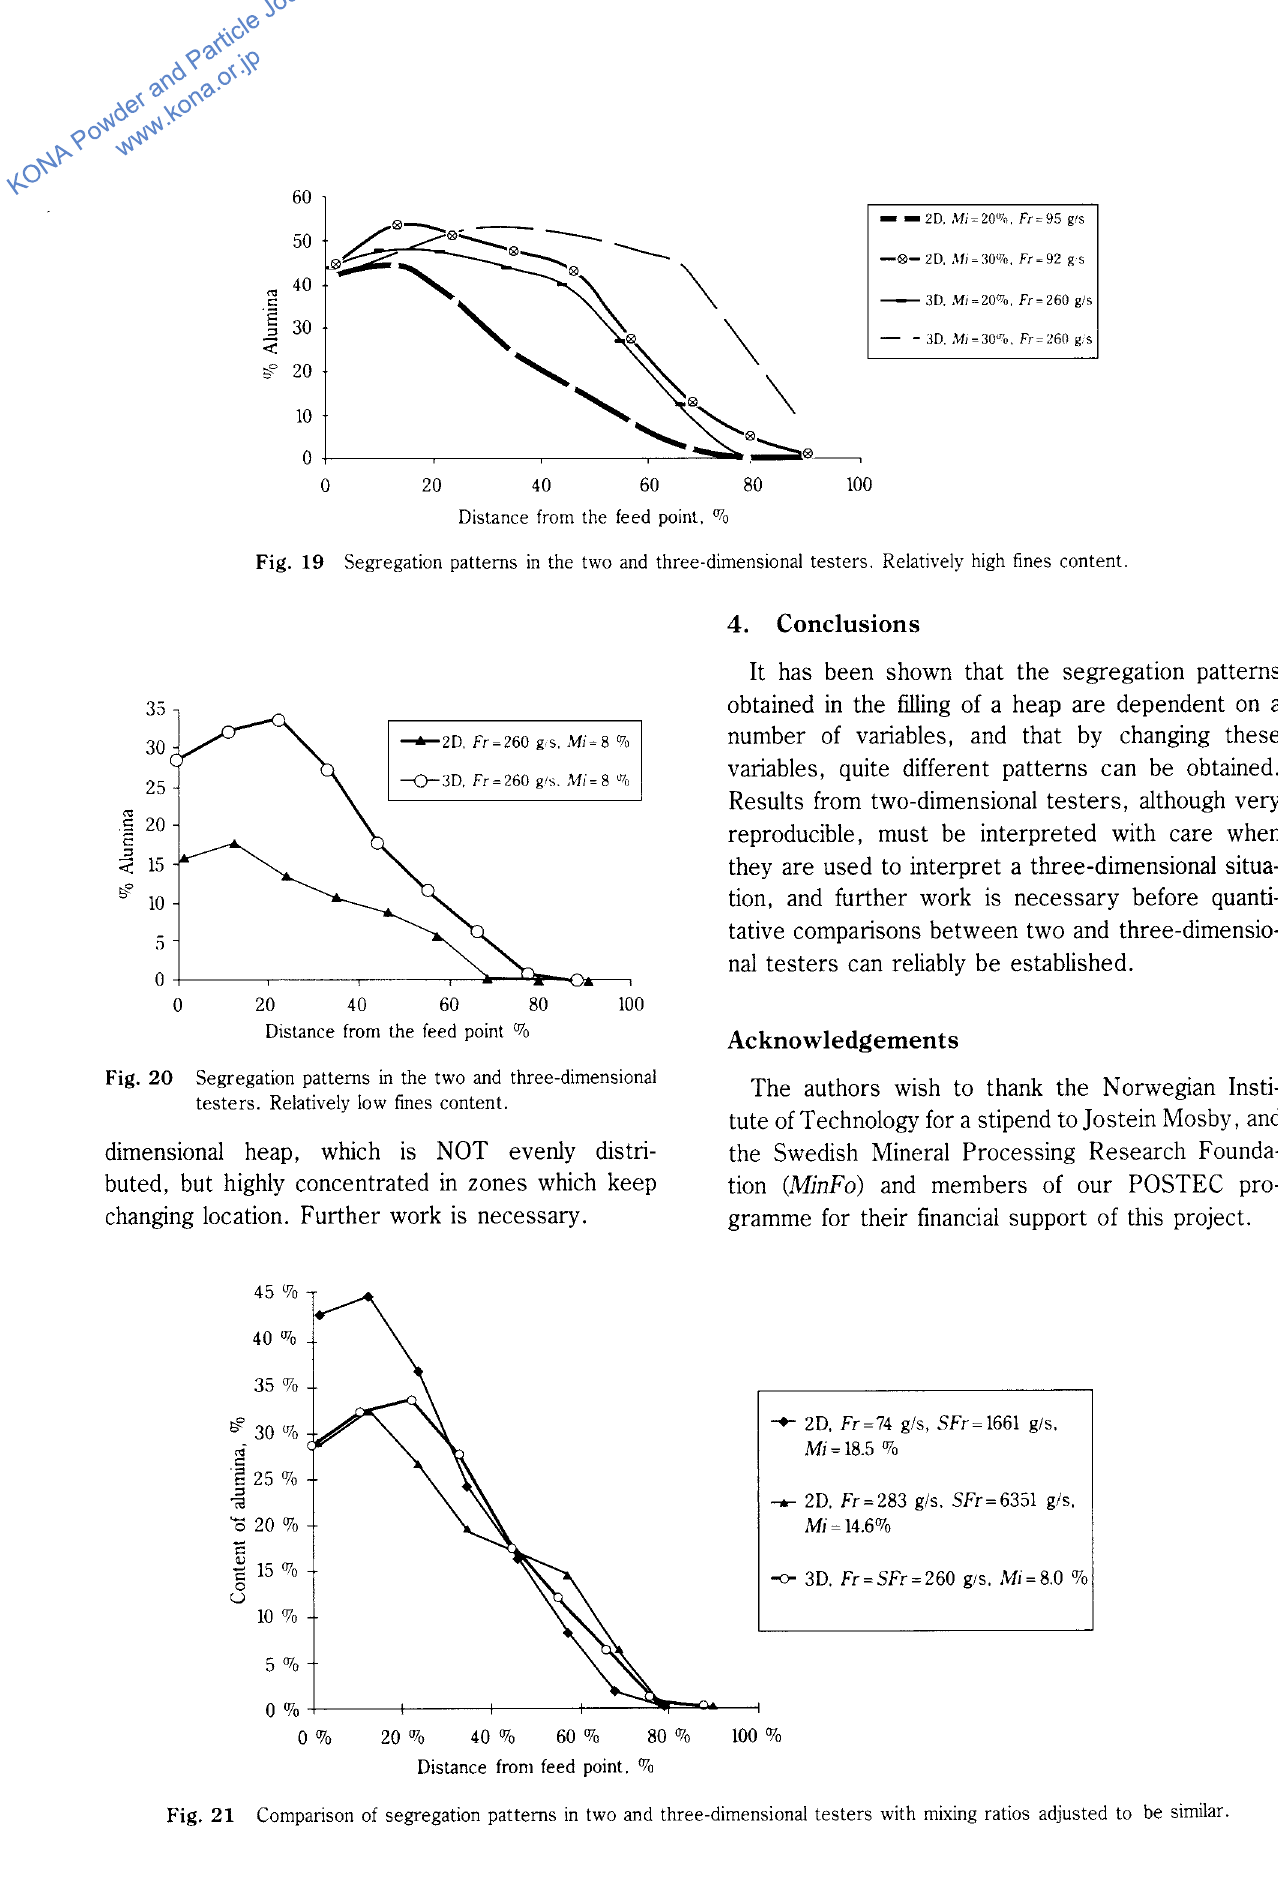
Fig. 21 Comparison of segregation patterns in two and three-dimensional testers with mixing ratios adjusted to be similar.